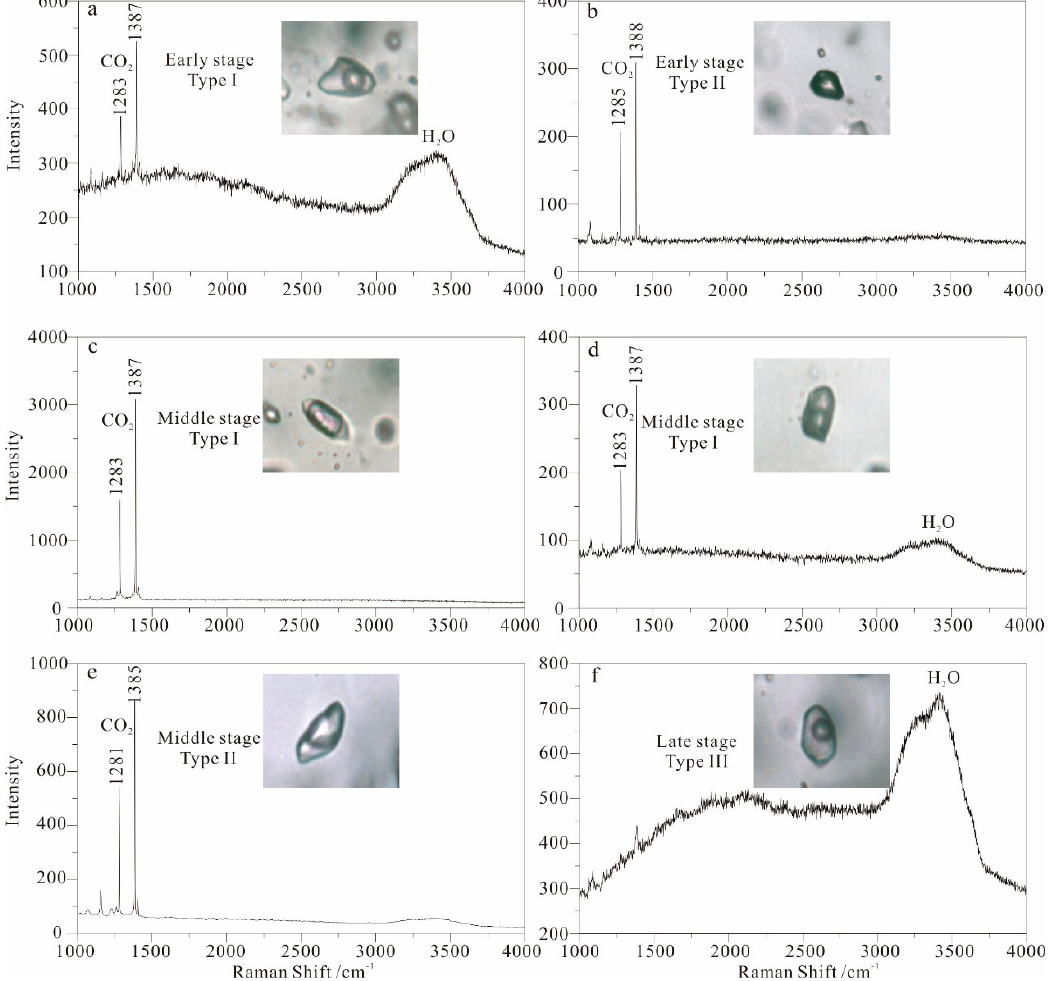
Figure 10. Representative Raman spectra of vapor bubbles for fluid inclusions from the Liyuan gold deposit. ( a ) CO 2 and H 2 O spectra of vapor in early-stage type I inclusions; ( b ) CO 2 spectra of vapor in early-stage type II inclusions; ( c ) CO 2 spectra of vapor in middle-stage type I inclusions; ( d ) CO 2